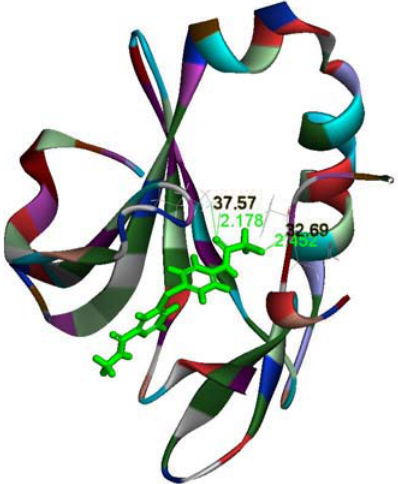
Figure 4. The binding mode of compound 6p with ATP pocket of Aurora-B kinase obtained by molecular docking experiments (PDB code: